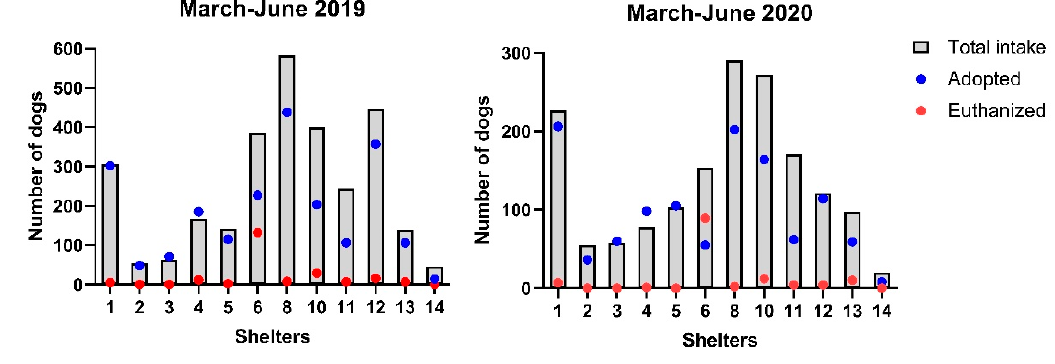
Figure 1. Dog intake, adoption, and euthanasia rates.